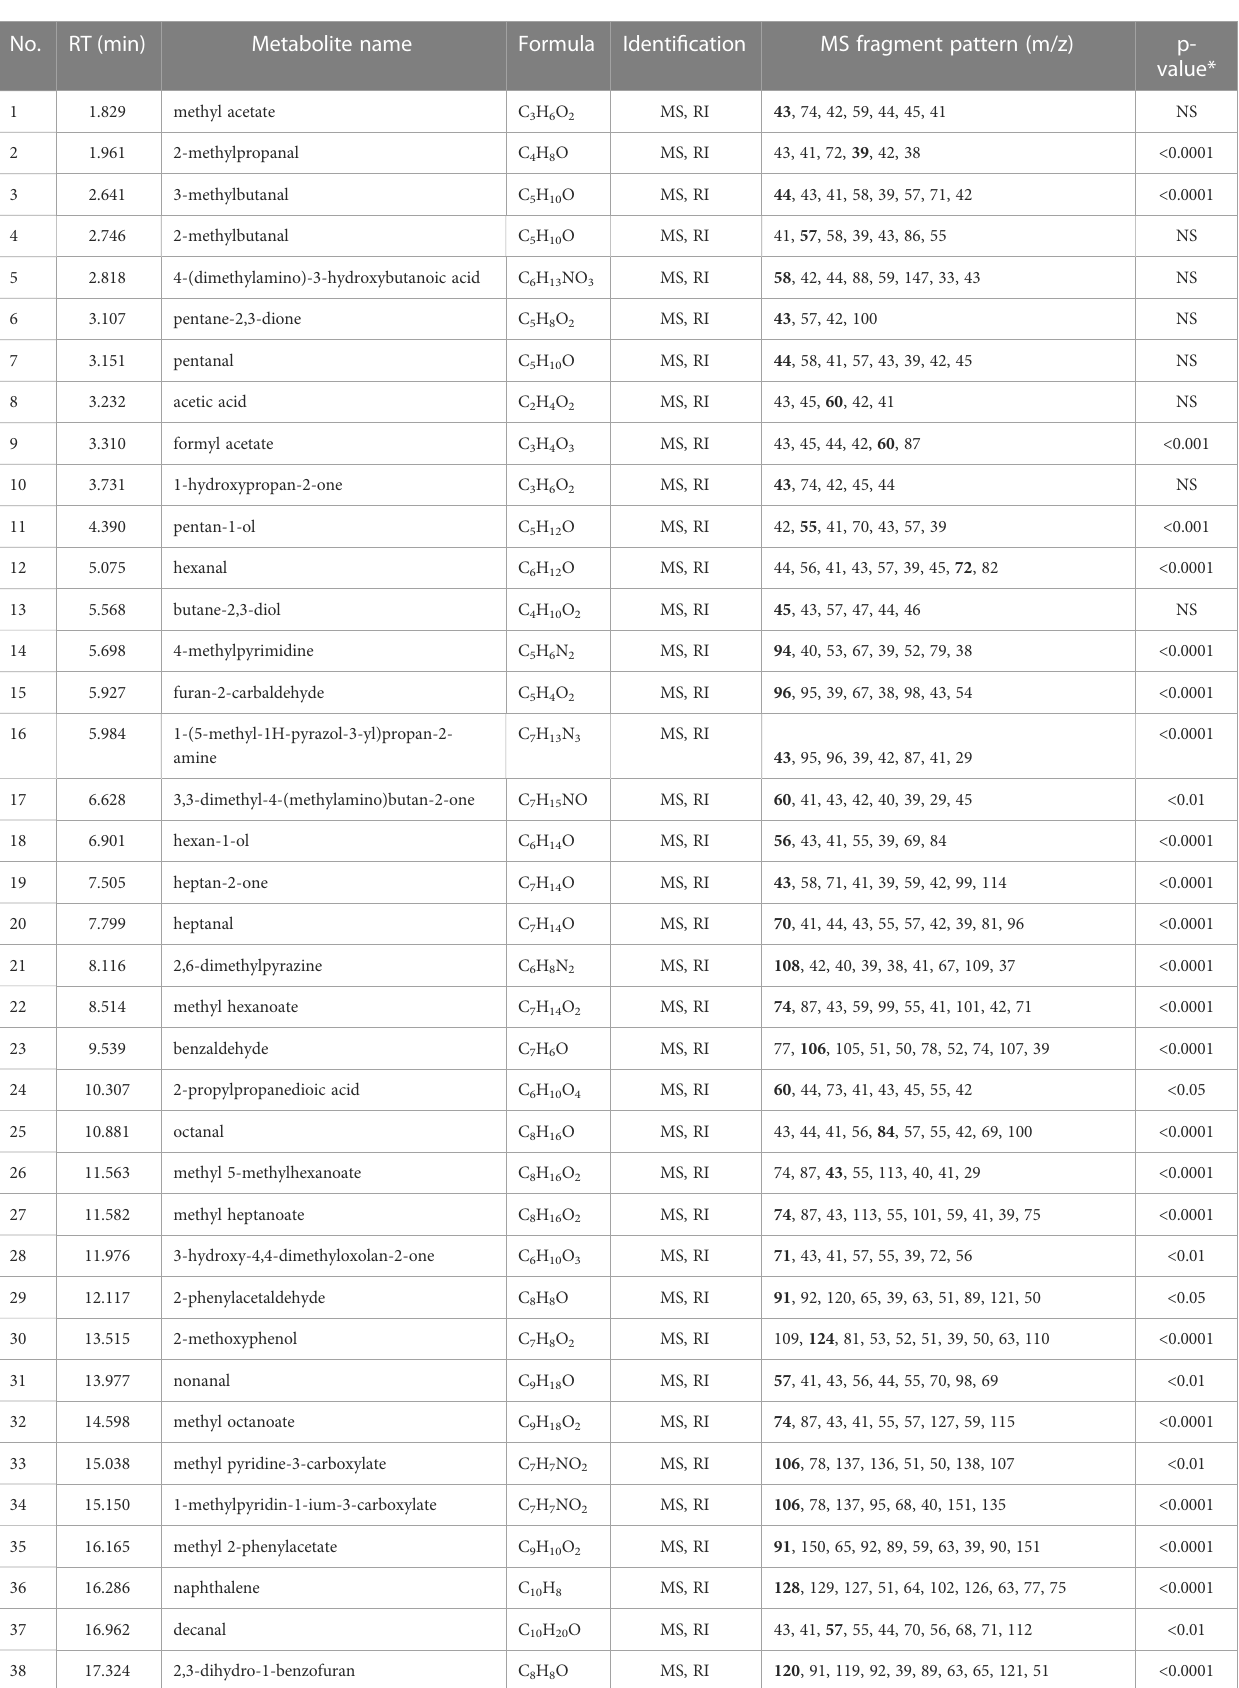
TABLE 2 Volatile compounds detected in aromatic white, aromatic black, non-aromatic black, and non-aromatic red rice samples. No. RT (min) Metabolite name